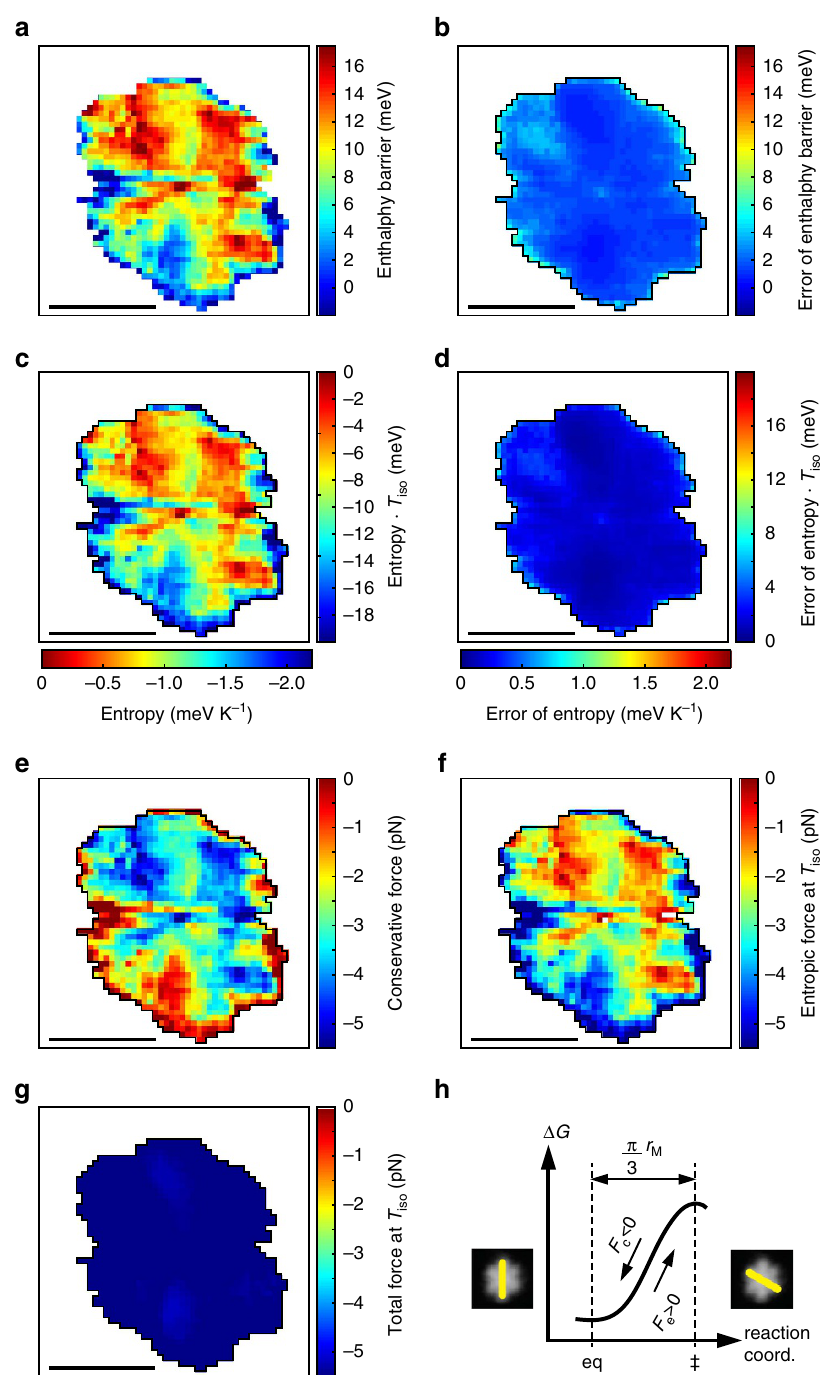
Figure 4 | Enthalpy, entropy and derived conservative and entropic forces derived from the data in Figure 2b–g. ( a ) Map of the enthalpy change D H z obtained by fitting the rate maps from Fig. 3a with the logarithmic form of equation (1) using equation (5) for the (weakly) temperature dependent attempt rate, and D H z ( x , y ) (cid:6) E (cid:2) ( x , y ). ( b ) Corresponding error. ( c ) Entropy difference D S z from the fit of ( a ). The right hand scale bar is a scale of the corresponding thermodynamic potential at T iso , which can be compared with ( a ). ( d ) Corresponding error. ( e ) Conservative force, derived from ( a ). ( f ) Entropic force at T iso , derived from ( c ). ( g ) Sum of conservative and entropic forces at T iso , from ( e , f ). ( h ) Schematic of the free energy change along the transition axis, indicating the sign convention for the conservative, F c , and entropic, F e , forces on the molecule. All errors in the figure are s.d. Scale bars in ( a – g ),